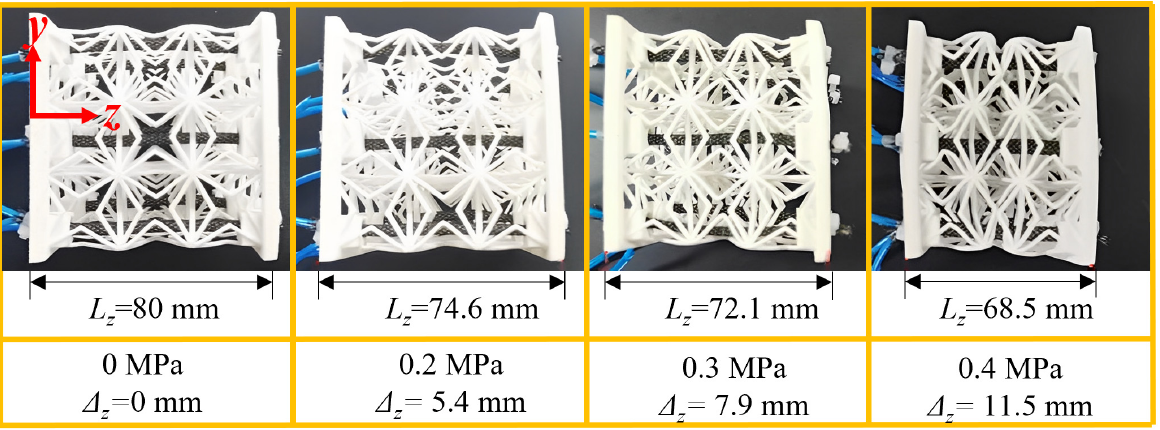
Figure 13. Unidirectional contraction of honeycomb under different input air pressure.